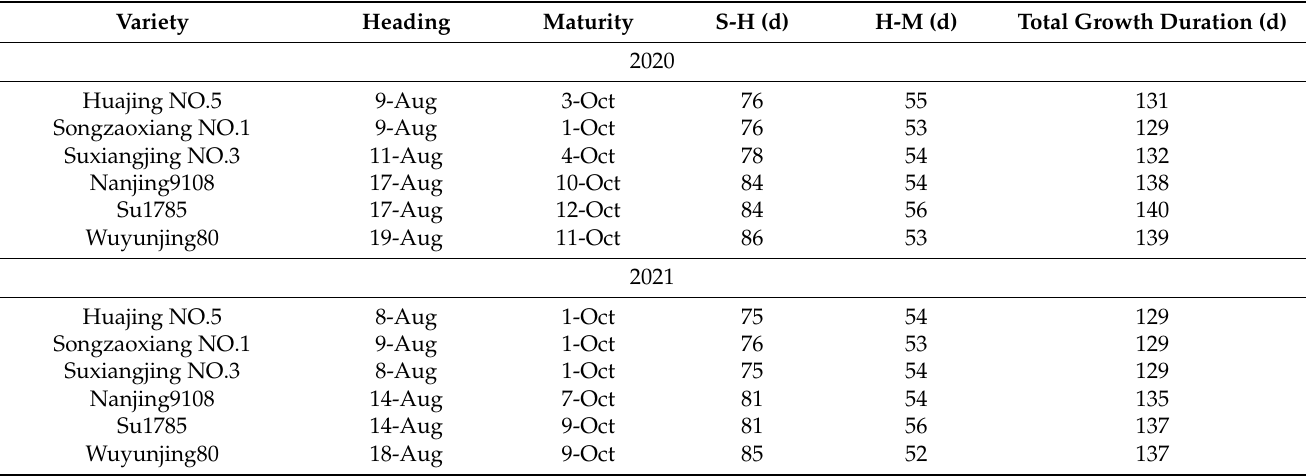
Table 1. Dates of heading and